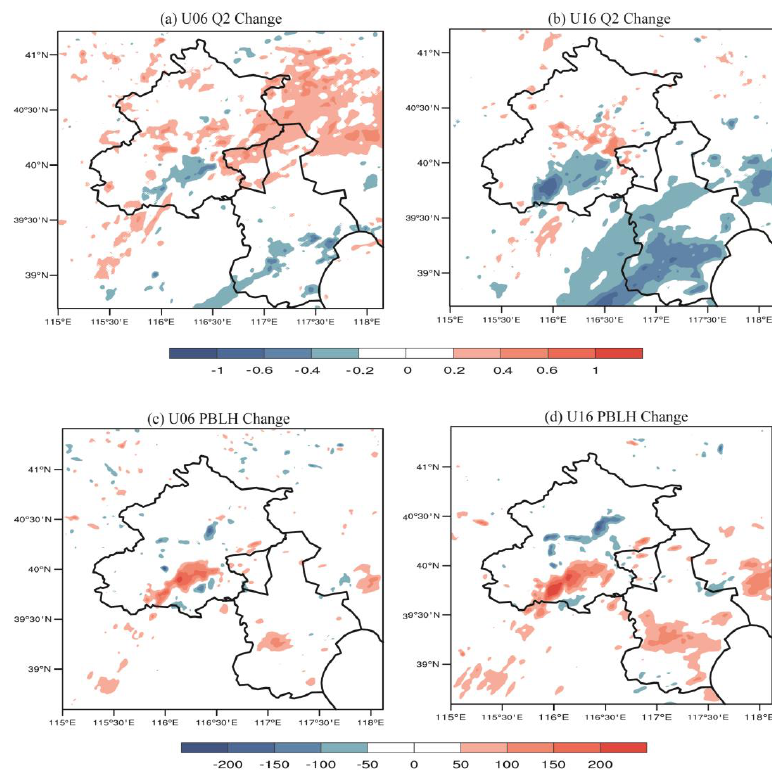
Figure 8. Changes in surface specific humidity (g kg −1 ) during the early period of precipitation (from 18:00 UTC on 19 July 2016 to 00:00 UTC on 20 July 2016). ( a ) Between the Urban06 test and No urban test; ( b ) between the Urban16 test and No urban test. ( c , d ) Same as ( a , b ) but for the atmospheric boundary layer height (units: m).